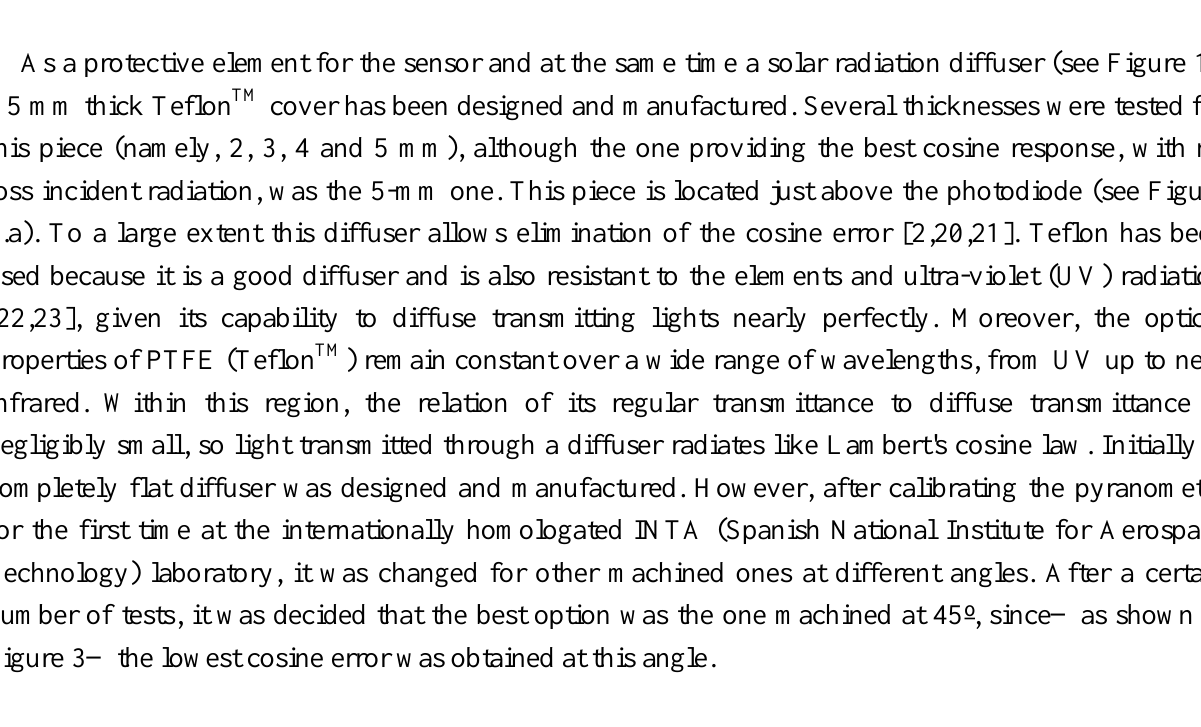
Figure 3. Deviation from ideal cosine response for different angles in the machined in the Teflon TM